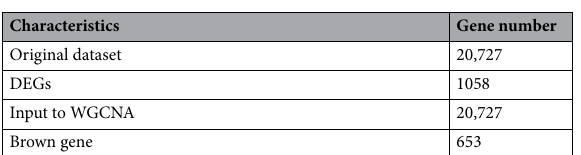
matrix structural constituent" and "identical protein binding". In addition, the KEGG enrichment pathways included "Metabolic pathways", "Protein digestion and absorption", "Chemical carcinogenesis", "Retinol metab- olism" and "Bile secretion". All enrichment pathways are shown in Fig. 2A. Ten hub genes (APOB, APOC2, APOA4, APOA1, CYP3A4, COL1A2, FN1, DPP4, ACAA2, HADHB) are shown in Fig. 2B.